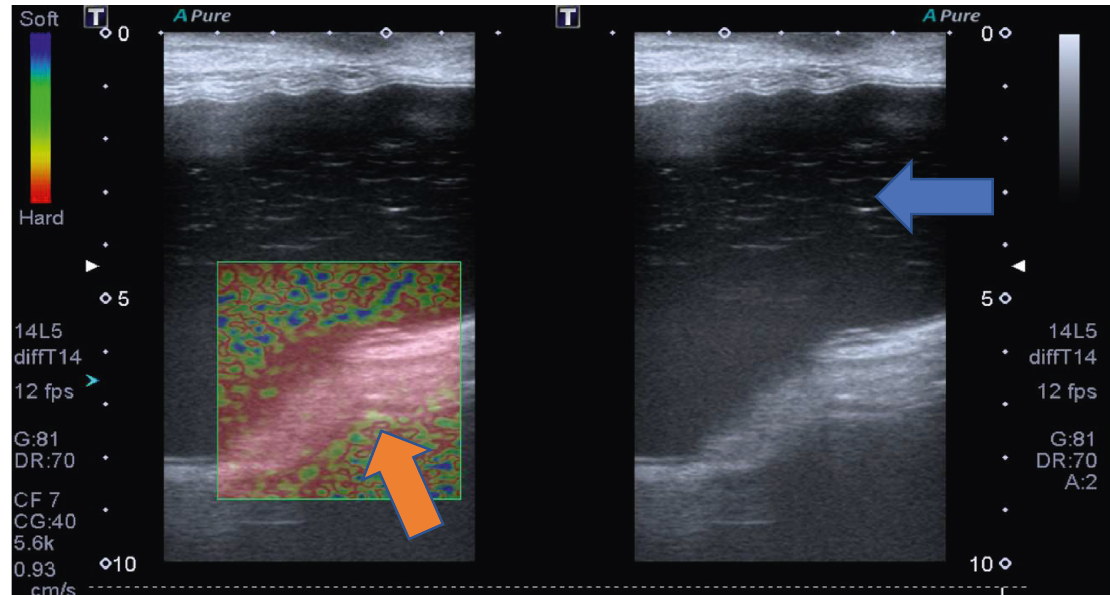
Figure 6: A 45-year-old patient with silicone implants for 7 years. Breast ultrasonography shows echotexture changes in the silicone implant contents (blue arrow) and an intracapsular mass associated with snowstorm artifacts, hard at elastography imaging compatible with silicone- induced granuloma of the breast implant